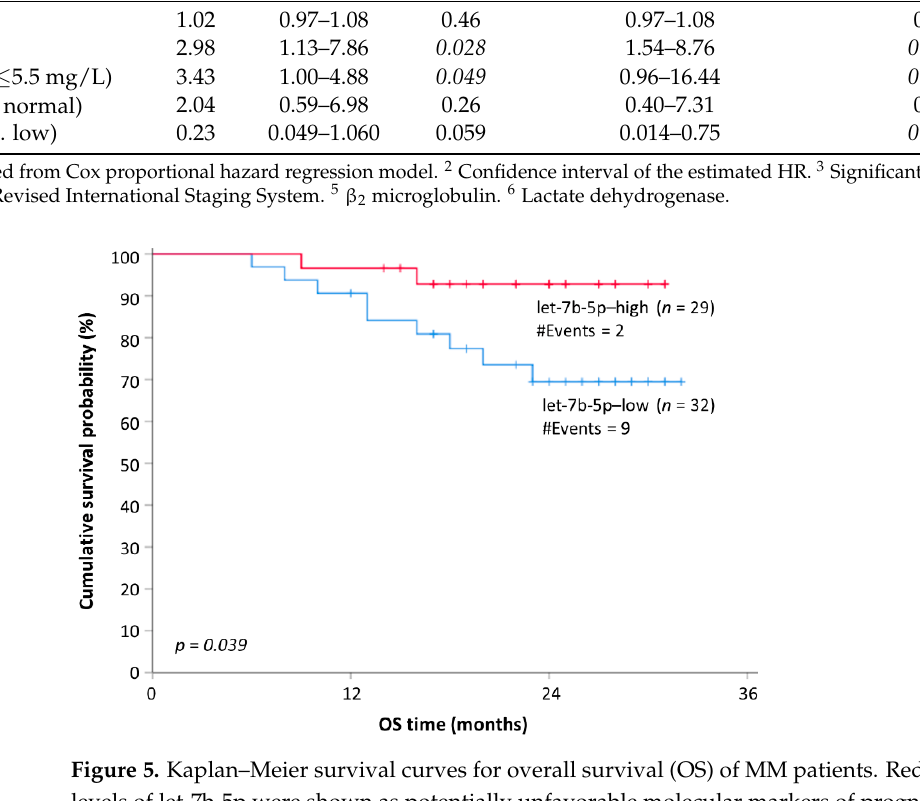
let ‐ 7b ‐ 5p (high vs. low)